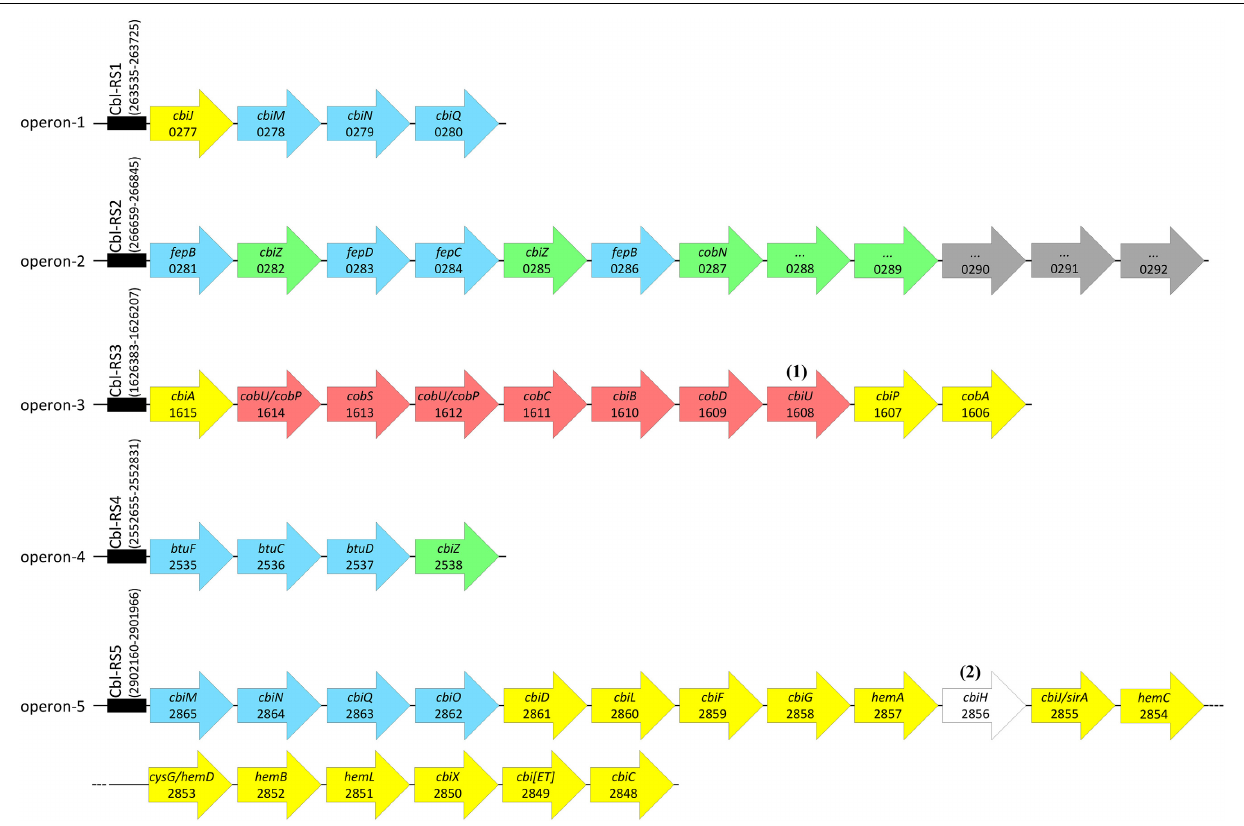
distinct pathways (see also Figure 1 ): upper corrinoid biosynthesis (UCB, in yellow), nucleotide loop assembly (NLA, in red), cobalt and corrinoid transporters (in blue) and corrinoid salvage (in green). Gray arrows depict genes that have no clear function in corrinoid biosynthesis. Gene names and corresponding gene loci (with the Dehre_# prefix removed) are given when available. Notes: (1) cbiU was newly annotated as a